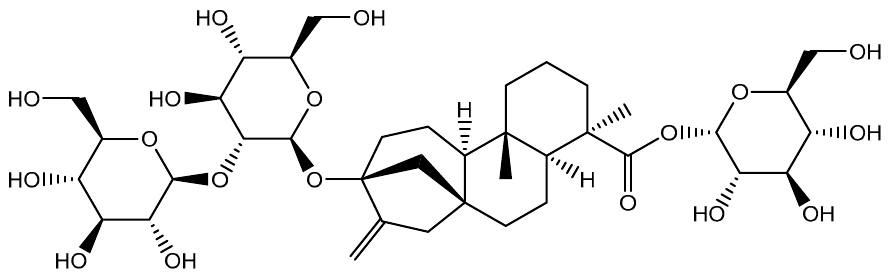
Figure 5. Stevioside ( Stevia rebaudiana Bertoni).